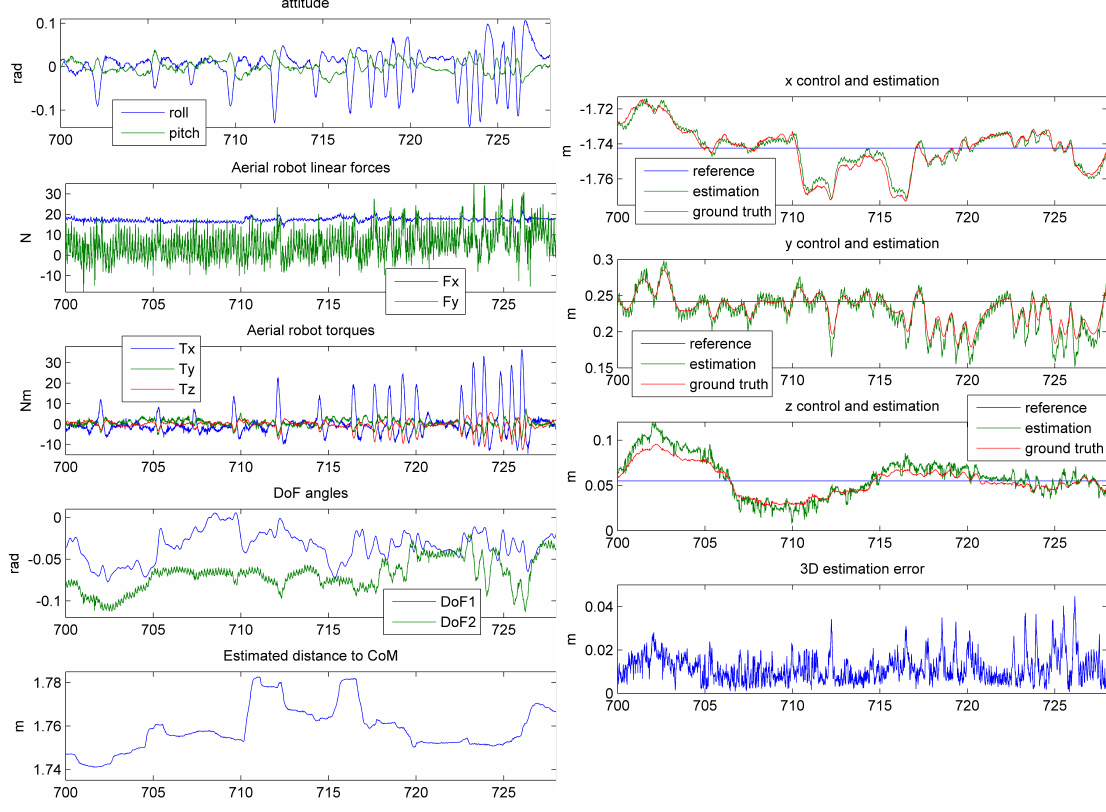
Figure 12. Telemetry of AeroX in fully-autonomous flight during contact in a robustness analysis experiments. The 100 N perturbations injected generated the response of the developed controller, which can be noticed in the robot attitude and torque graphs. On the right, the robot relative position w.r.t. the surface contact point is shown together with the ground truth and the reference values for each axis. The robot position error w.r.t. the reference value in each axis was lower than 6